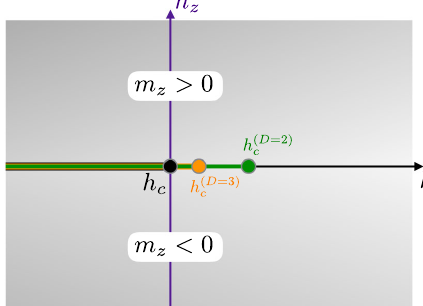
FIG. 1. Phase diagram of the ferromagnetic ( J ¼ 1 ) transverse- field Ising model with an additional longitudinal field h z . The thick, colored lines for h < h c or h < h zontal extent of the spontaneous symmetry-breaking line at h ¼ 0 . z